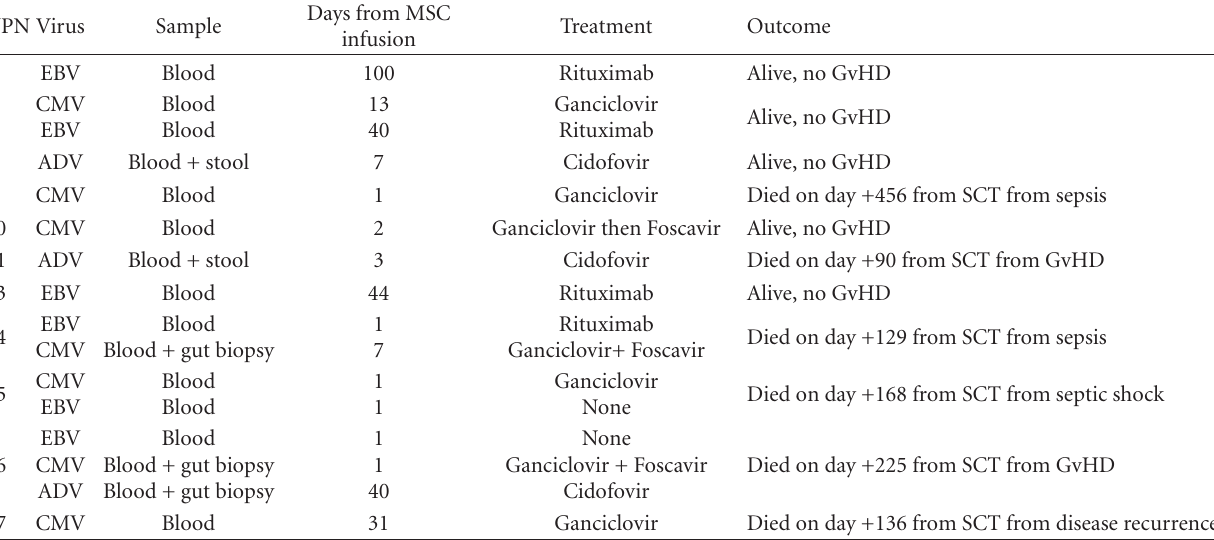
Table 2: Viral reactivations